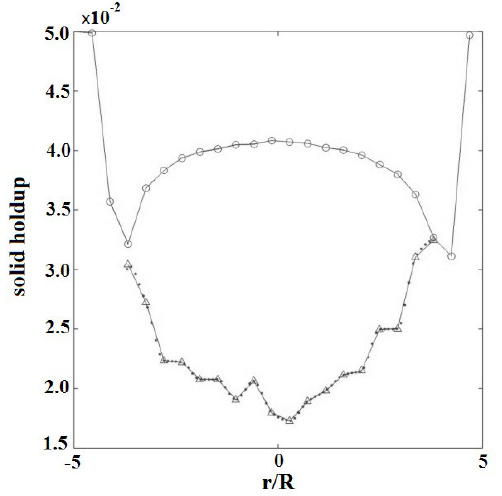
Fig. 5. Radial distribution of solid hold up depicted as tri- angles, interpolation points and tube-riser profile depicted as circles.